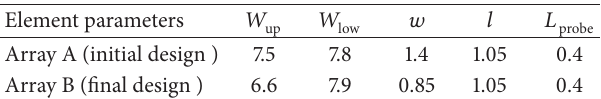
Table 1: The structural parameters for the radiating element (unit: